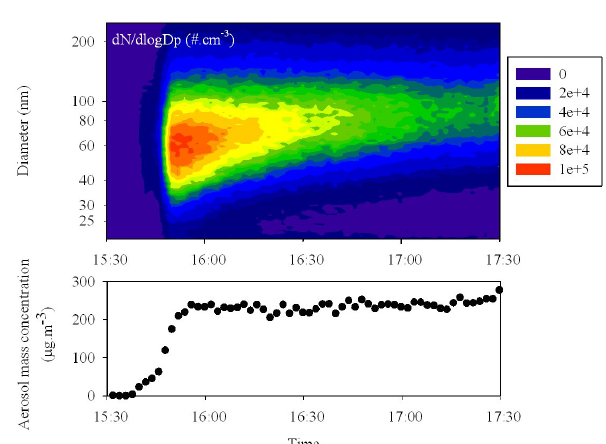
Fig. 10. Time dependent plot of the behavior of ammonium sulfate particles ((NH 4 ) 2 SO 4 ) injected in CESAM chamber. Top panel: aerosol size distribution in number as measured with SMPS; bot- tom panel: aerosol mass concentration derived from SMPS mea- surement assuming a density of 1.77gcm − 3 for (NH 4 ) 2 SO 4